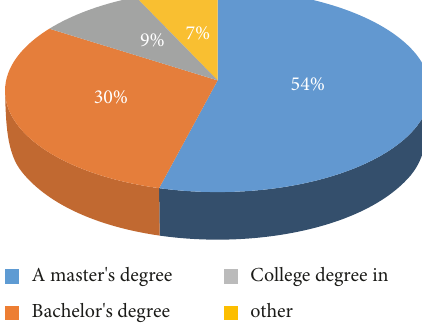
Figure 5: Authoritative satisfaction survey of internal audit of insurance company A .